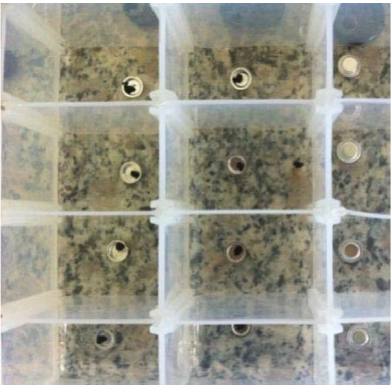
Figure 3: DSC test